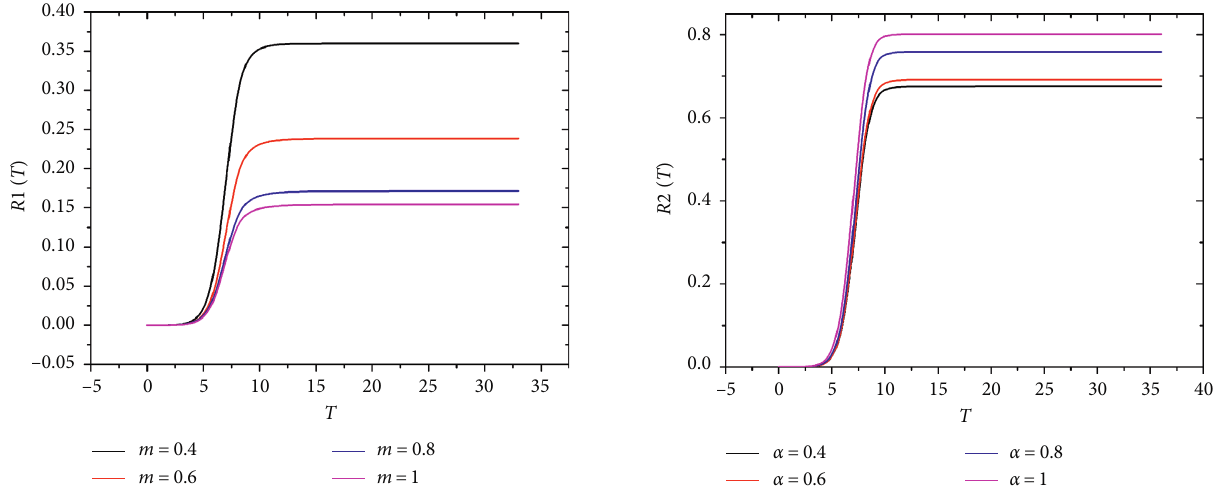
Figure 7: Density of stifler2 over time for different values of α